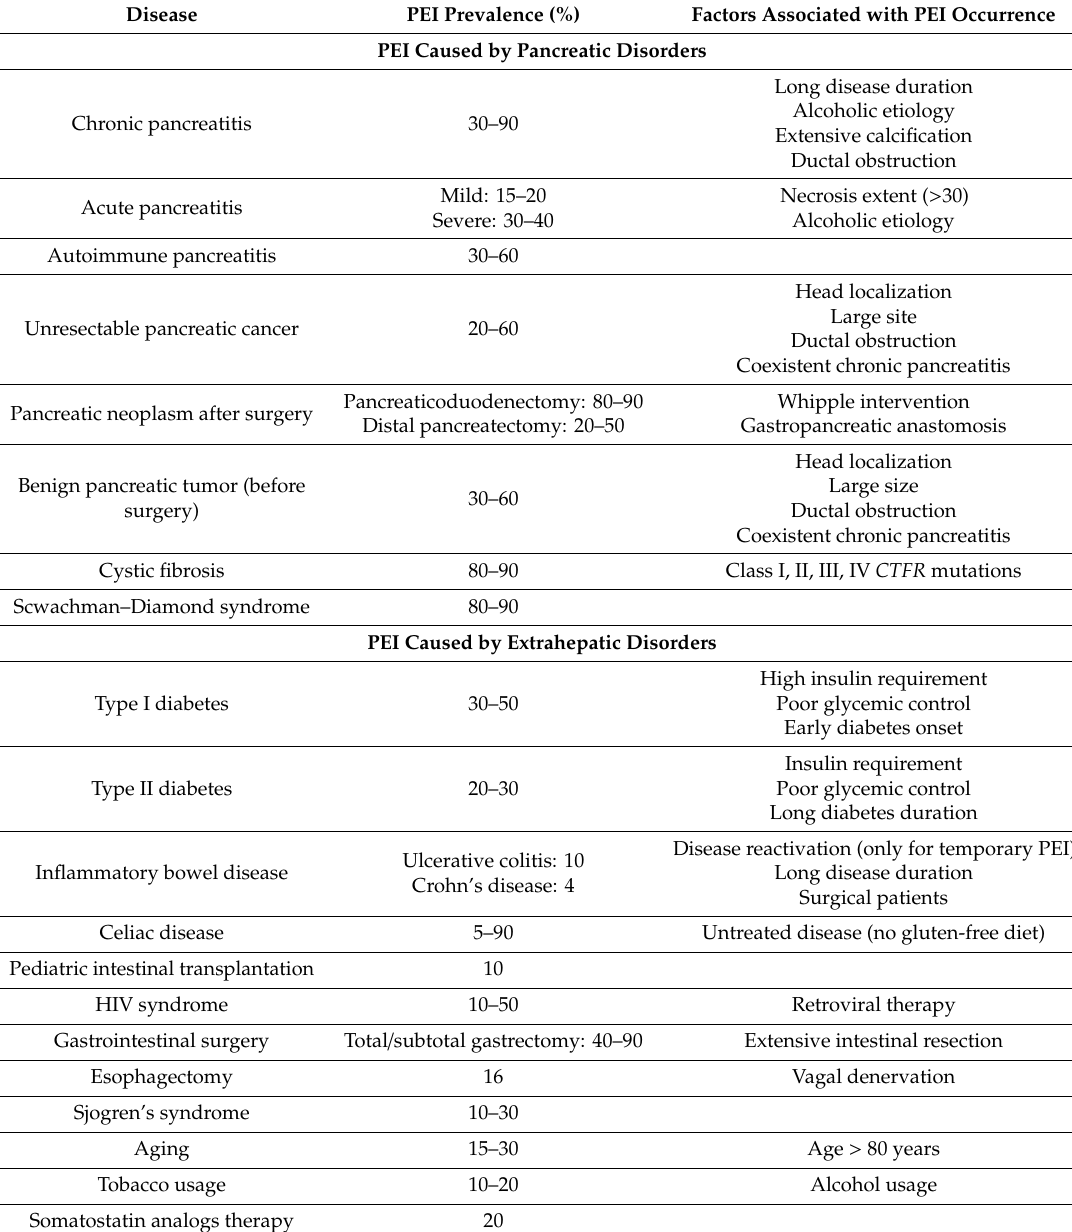
Table 2. Prevalence and factors associated with pancreatic exocrine insu ffi ciency (PEI) in di ff erent clinical